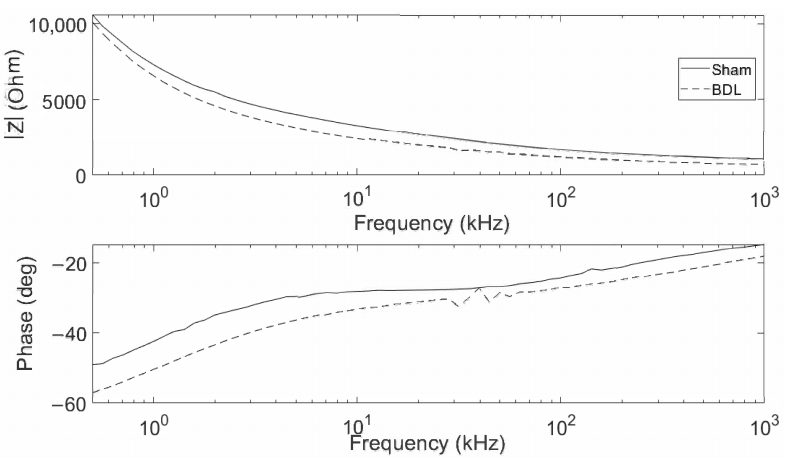
Figure A4. Impedance magnitude of day 15 sham-operated and BDL tissue biopsies obtained through direct insertion of needle electrodes into the tissue. The frequency was between 500 Hz and 1